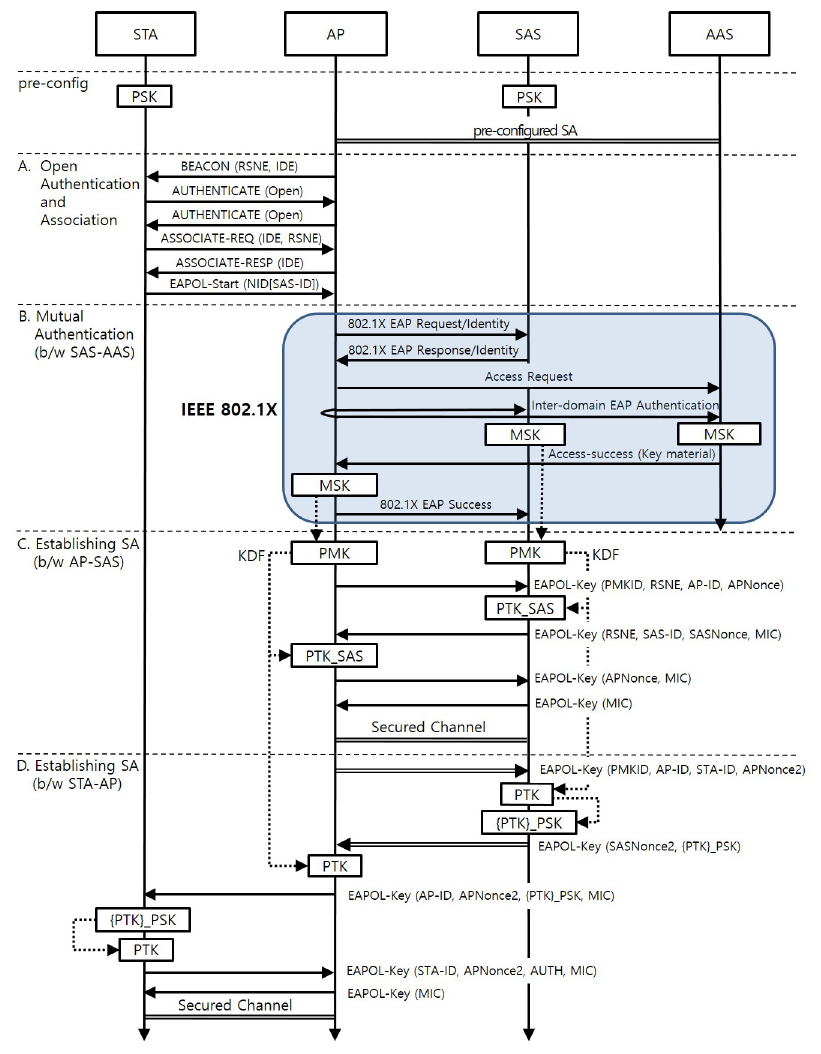
Figure 4. Sequence Diagram of the Proposed